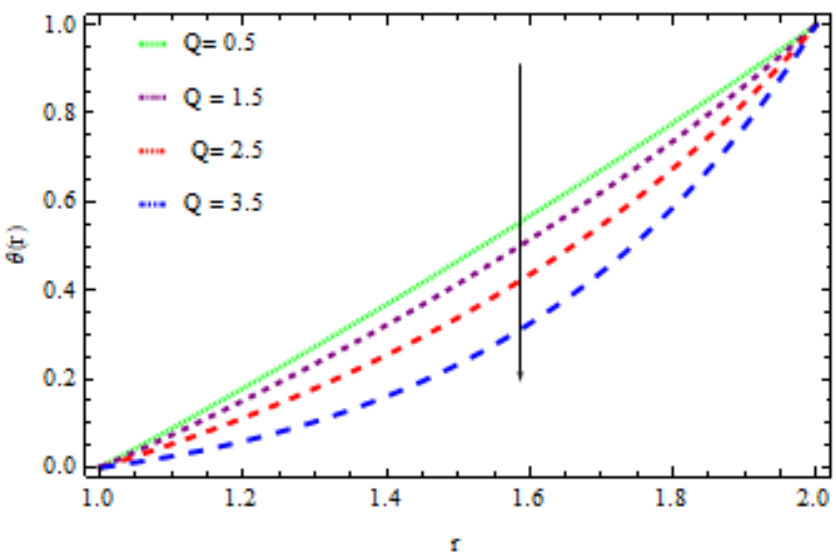
Figure 10. The influence of Q on temperature when B r = 0.1, M = 0.6, N = 0.2, K p = 0.5, ε = 1.5.